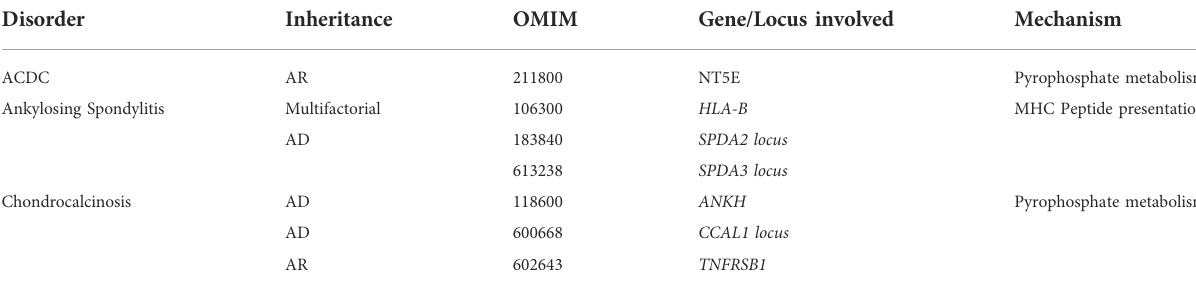
TABLE 6 Rheumatic disorders previously seen coexisting with OSL. AD stands for Autosomal Dominant, AR for Autosomal Recessive. Lack of inheritance means that it is not con fi